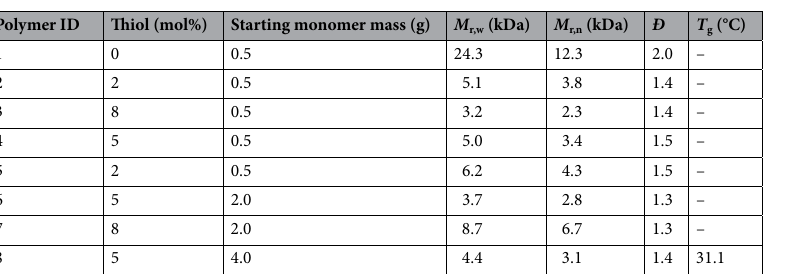
Figure 2. The formation of the trans -sobrerol acrylate homopolymer (TPA6) and the trans -sobrerol acrylate/ acrylated oleic acid copolymer (TPA7). Polymer